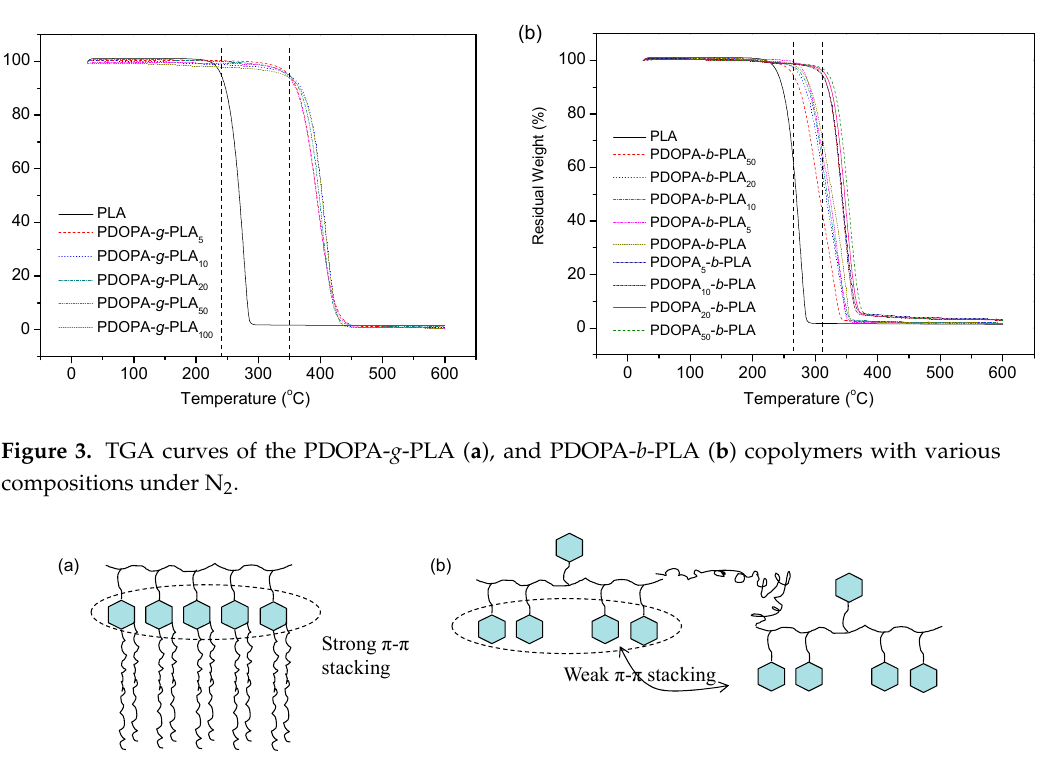
Figure 4. Remaining weights of PDOPA- g -PLA ( a ) and PDOPA- b -PLA ( b ) with degradation time in buffer solution at pH 10.2.